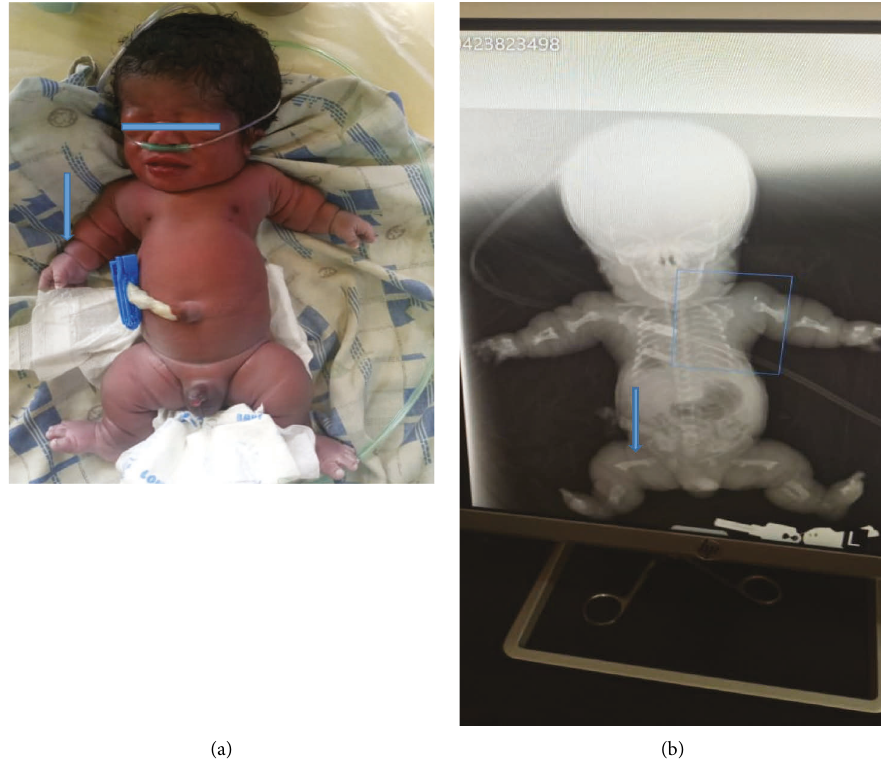
Figure 2: (a) A clinical photograph of baby 2 with thanatophoric dysplasia: large head prominent skin folds (arrow), narrow chest, and short limbs. (b) A plain radiograph of baby 2 with features of TD type 1. The arrow shows a curved telephone-handle